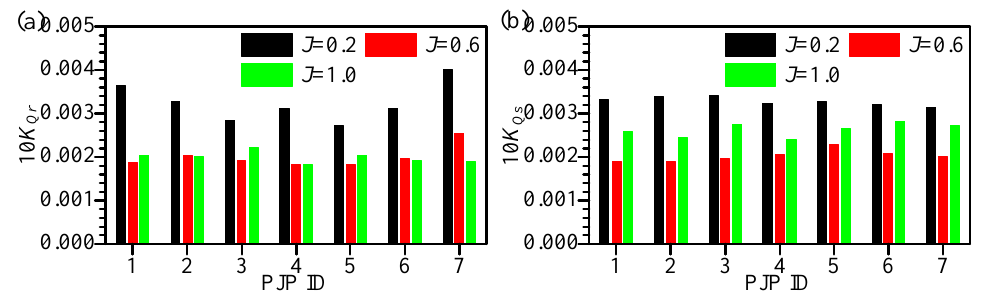
Figure 13. RMSE values of the fluctuation component of torque: ( a ) 10 K Qr , ( b ) 10 K Qs .